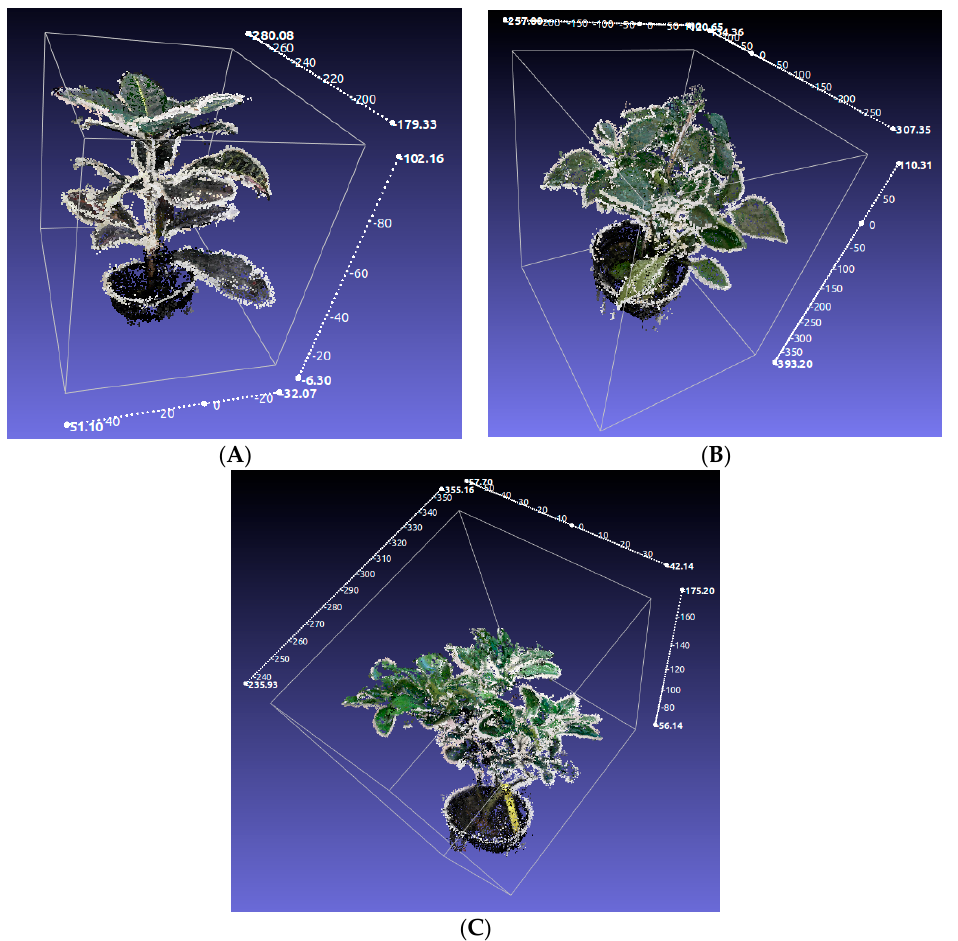
Figure 9. Reconstructed plants. ( A ) croton; ( B ) pepper; ( C ) lemon.